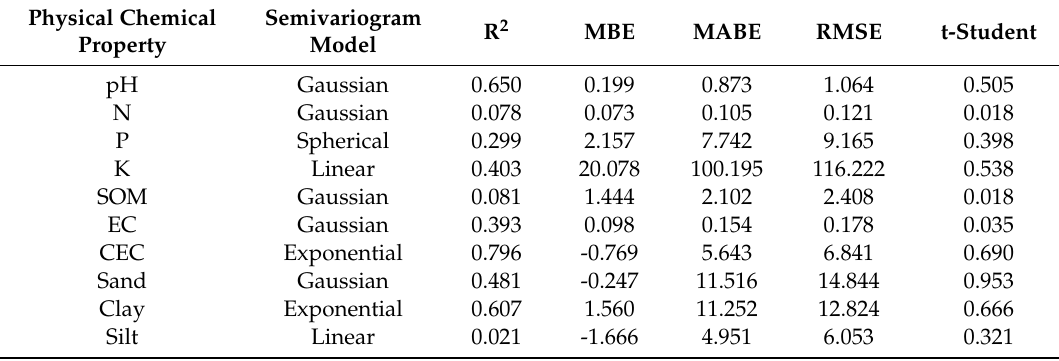
Table 5. Best performing semivariogram model for each physical chemical soil property in the Jucusbamba and Tincas microwatershed (NW